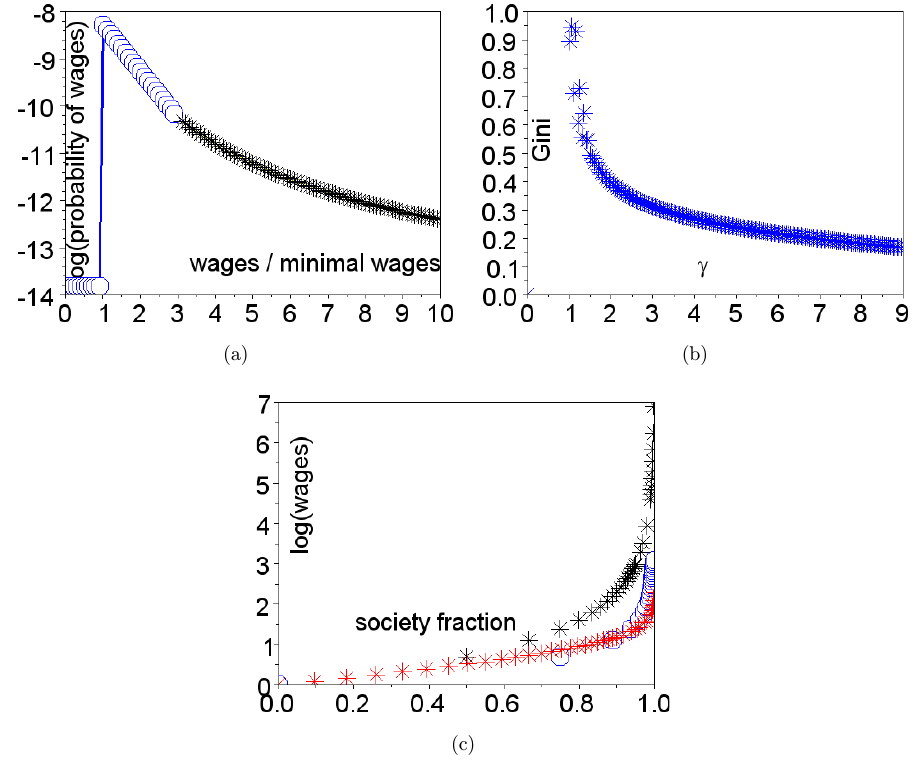
Fig. 3. (a) A log linear plot of the combined case income density function. The vertical curve is (cid:3) , the light blue curve (circles) is the exponential income curve with (cid:4) ¼ (cid:3) , and the black curve (stars) is the Pareto curve with (cid:5) ¼ 1 , (b) The Gini for the combined income density function as a function of the (cid:5) , with (cid:4) ¼ 1 : 4 (cid:3) , where the fair Gini is where (cid:5) (cid:6) 2 , and (c) The society income curve on a log linear scale, with normalization, wages/minimal wages ( y axis). This function is the income of every percentile in the society. Red curve is the exponential income curve (lower curve, stars), blue curve is Pareto income curve with (cid:5) ¼ 2 (circles) and the black curve is the Pareto income curve with (cid:5) ¼ 1 (upper curve, stars). It is clear that the top 0.1% are very rich just in the Pareto (cid:5) ¼ 1 curve, while in the other cases, each curve is continuous and the rich are just moderately